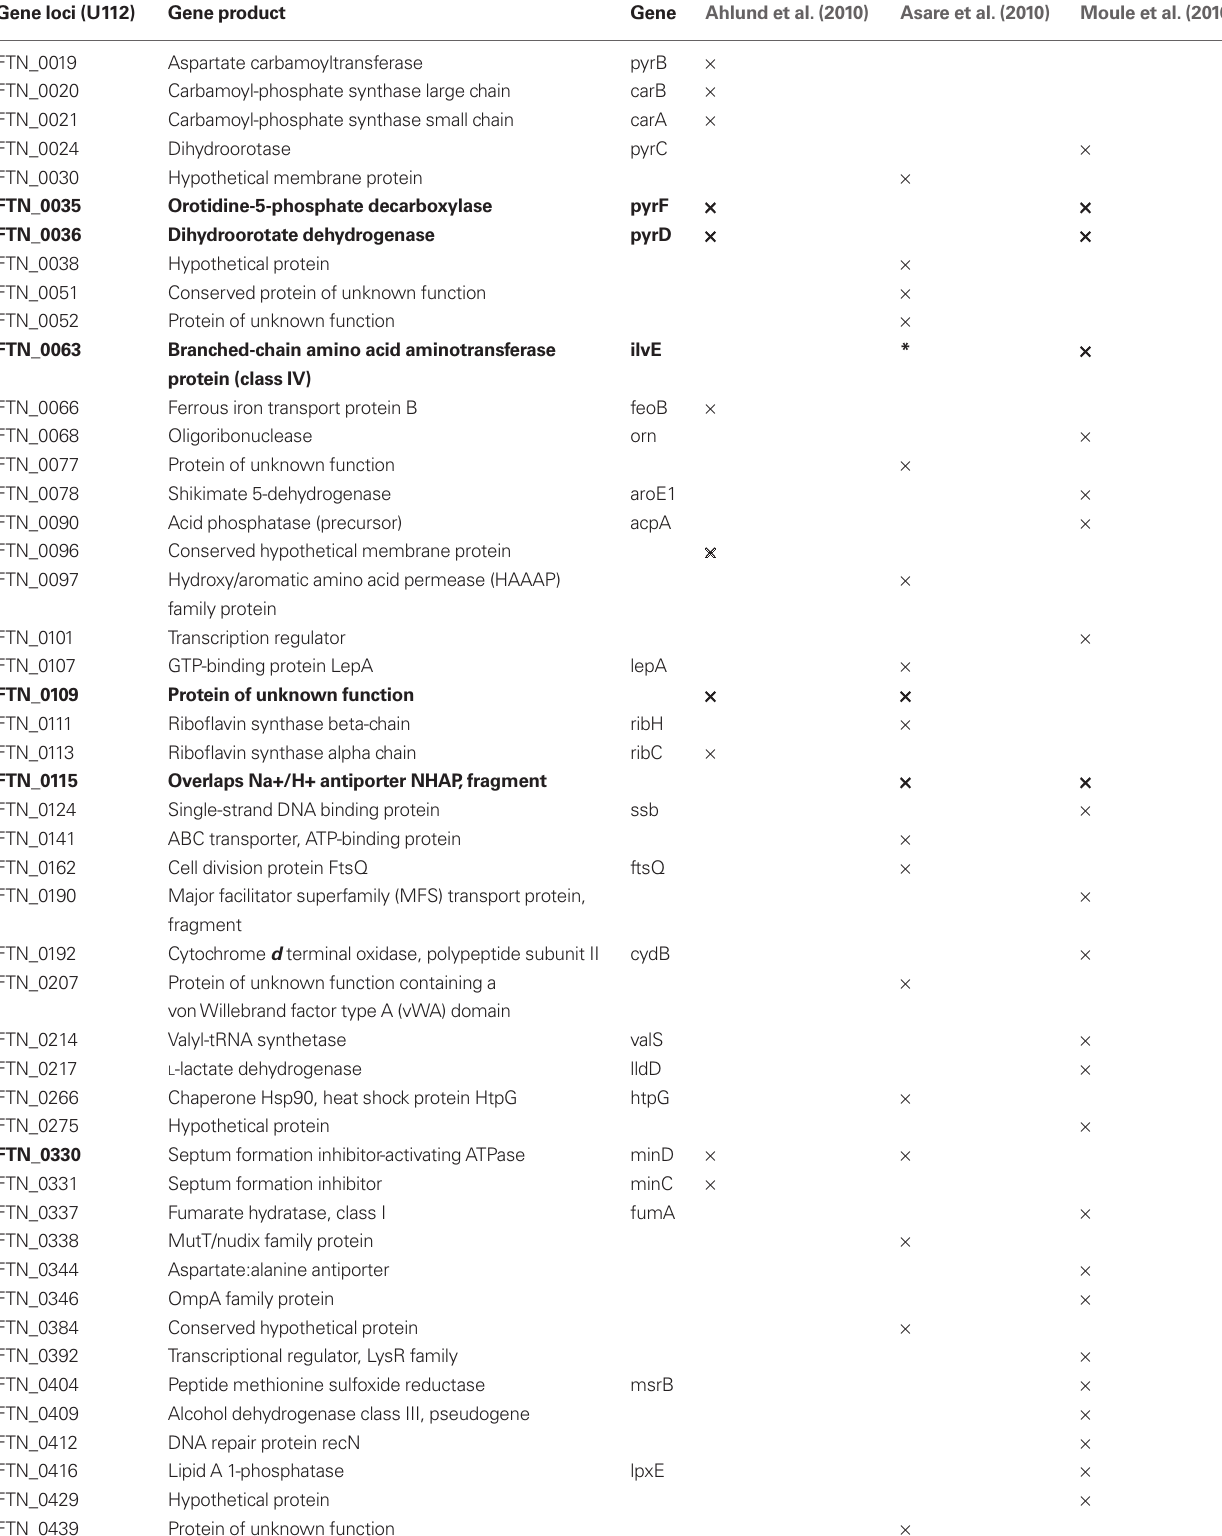
Table 1 | A combined list of genes essential for F. tularensis lethality to adult fruit flies. gene loci (u112) gene product gene Ahlund et al. (2010) Asare et al. (2010) Moule et al.